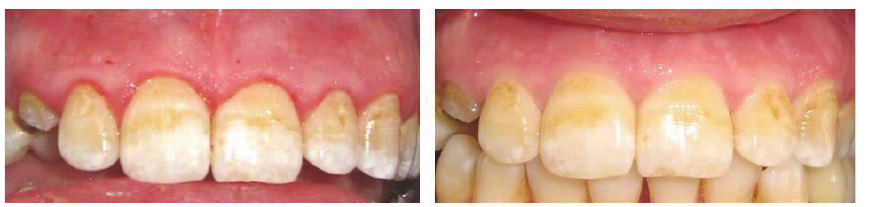
Figure3: Preoperativephoto :thispatientwasreferredfromtheoralsurgerydepartmentforhygienereinforcementpriortoimmediateimplant in relation to the upper right canine. Postoperative photo revealed total improvement of the gingival inflammation after 2 vitamin C injections.